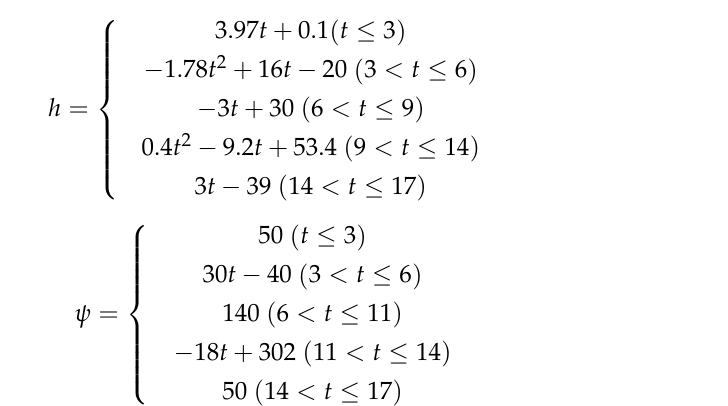
( b ) ( c ) Figure 12. The three directions the UAV traveled. ( a ) North direction flight distance; ( b ) East direc- tion flight distance; ( c ) Altitude flight distance.